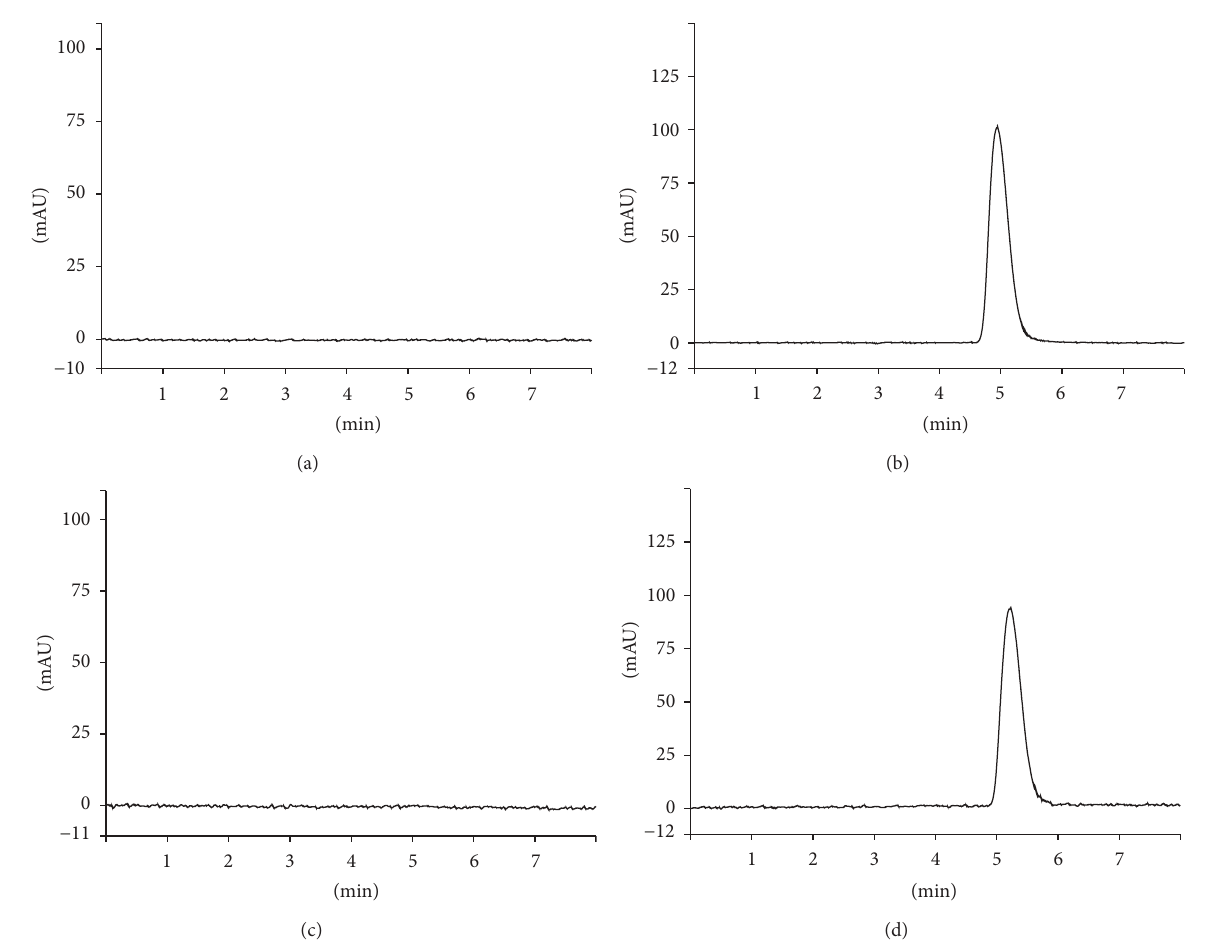
Figure 3: HPLC chromatograms ( 𝜆 = 320 nm) obtained from unloaded and FA-loaded microparticles: M1FA0 (a), M1FA10 (b), M2FA0 (c), and M2FA10